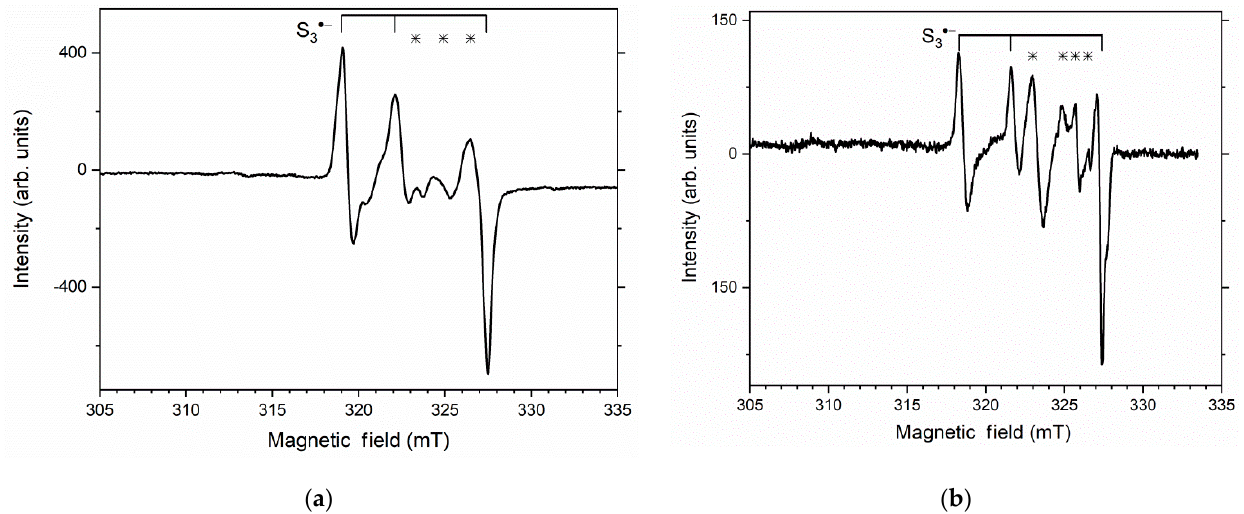
Figure 14. ESR spectra of afghanites from Sar-e Sang, Sample 9 ( a ), and Ladgvardara, Sample 10 ( b ), measured at 77 K.